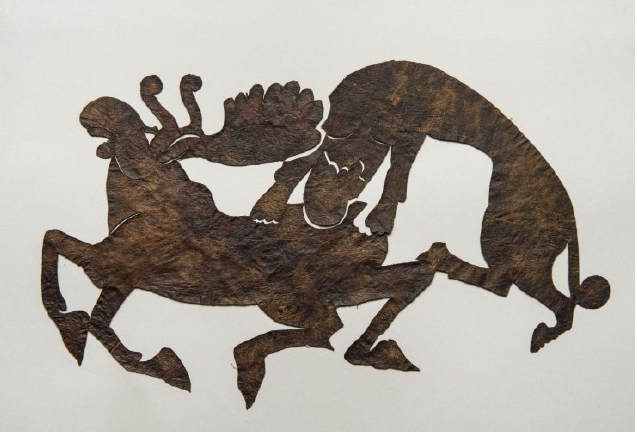
Figure 11. Saddle cover showing a feline attacking a moose (SHM inv. no. 1295 ‐ 250); leather; Kurgan 1, Pazyryk, Altai mountains, Russia; late 4th to early 3rd century BC. [Image is used from